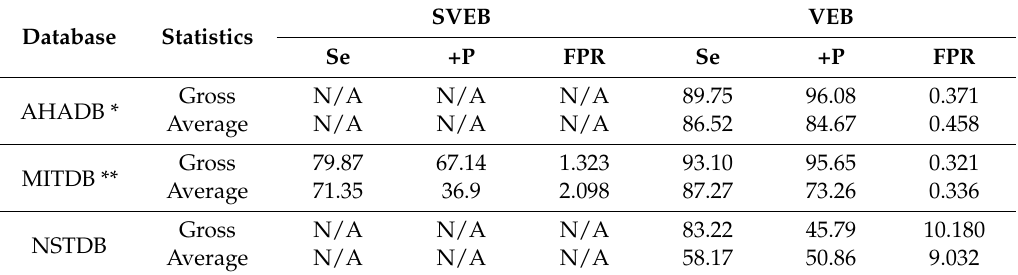
Table 2. The entire supraventricular ectopic beat (SVEB) (i.e., APC) and ventricular ectopic beat (VEB) (i.e., VPC) evaluation result. (* = exclude records 2202, 8205; ** = exclude records 102, 104, 107, 217;